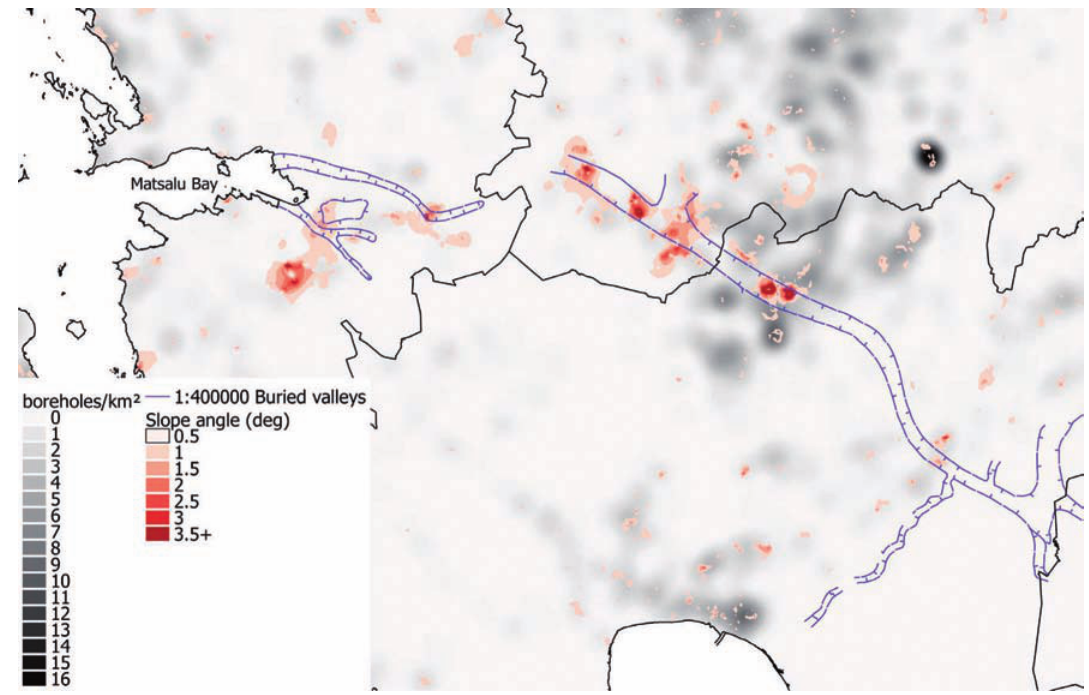
Fig. 10. The rock head elevation (RHE) model of the border area of Pärnu and Lääne counties (area c in Fig. 1). The density of boreholes in this area is low and questions arise about the true locations and directions of the buried valleys of older models. The mapped valleys proceeding east of Matsalu Bay are not supported by the RHE model whilst some steep slopes south of the bay could point at undetected buried